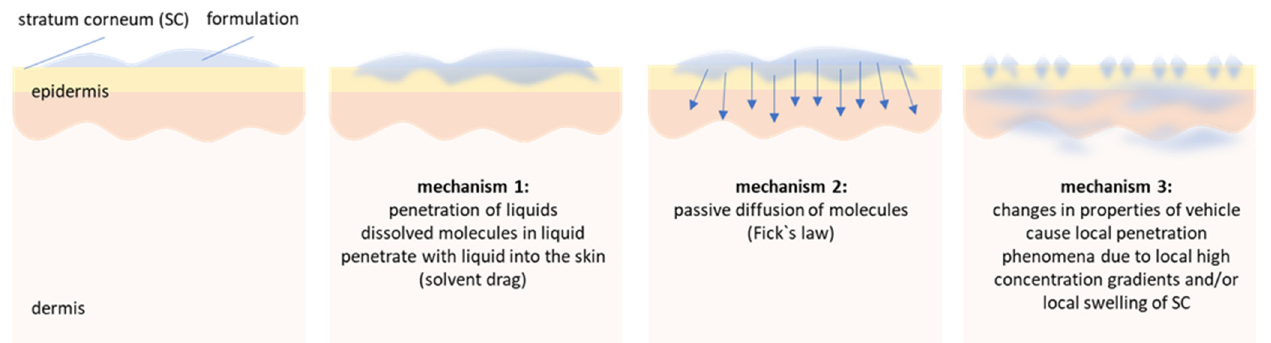
Figure 1. Proposed mechanisms of dermal penetration. First mechanism: penetration of low viscous liquids—active compounds penetrate via convection (solvent drag mechanisms) into the skin. Sec- ond mechanism: vehicle and skin are in equilibrium—AI penetrate via passive diffusion. Third mechanism: transformation of vehicle creates passive penetration phenomena—one example is the particle-assisted penetration enhancement, i.e., the formation of aqueous menisci below particulate materials that increase the penetration of AI being dissolved in the liquid of the meniscus [3]. It is likely that the different mechanisms occur not stepwise but superimpose each other. The figure and the figure legend are re-printed from [2].